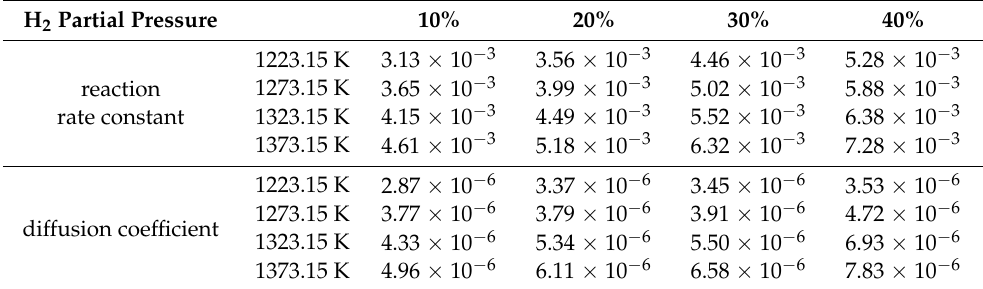
Table 4. Reaction rate constant diffusion coefficient for various gas compositions and temperatures.